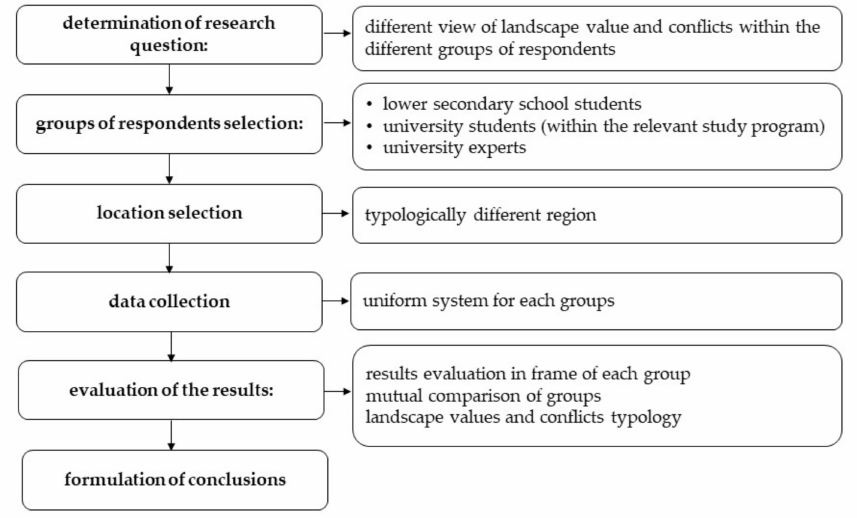
Figure 1. Overview of the methodological approach of the pilot